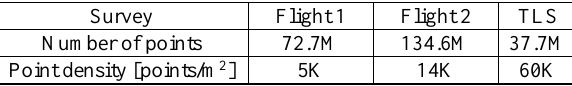
Table 2. Approximated number of points collected at test site and average point density in test